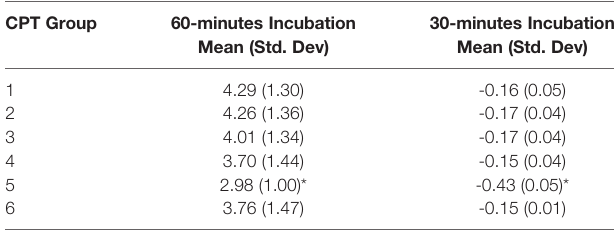
TABLE 6 | Summaries of proportional change of monocyte chemiluminescence by CPT groups, under 60- or 30-minutes